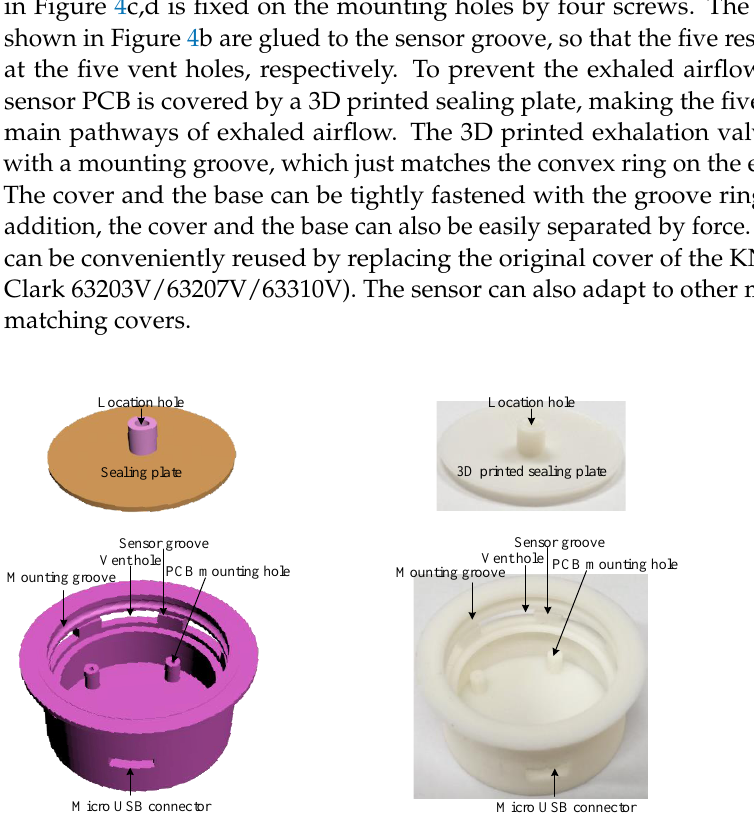
( b ) The 3D printed cover. Figure 8. The design and realization of the exhalation valve cover. The assembled sensor weighs 11.21 grams and measures 44 × 44 × 18 mm 3 . Compared with the original exhalation valve cover of 2.27 g, it only adds a small weight of 8.94